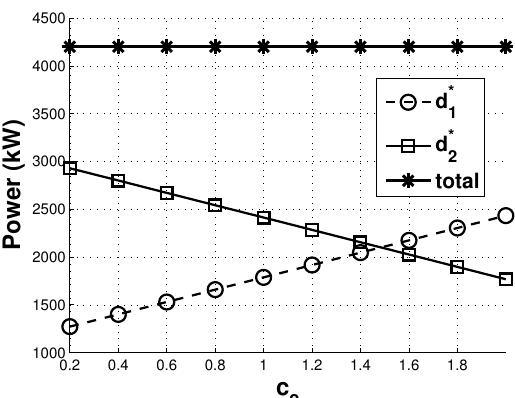
Figure 2. The demand distribution to suppliers 1 and 2 ( δ = 0.016) as the price offered by supplier 2